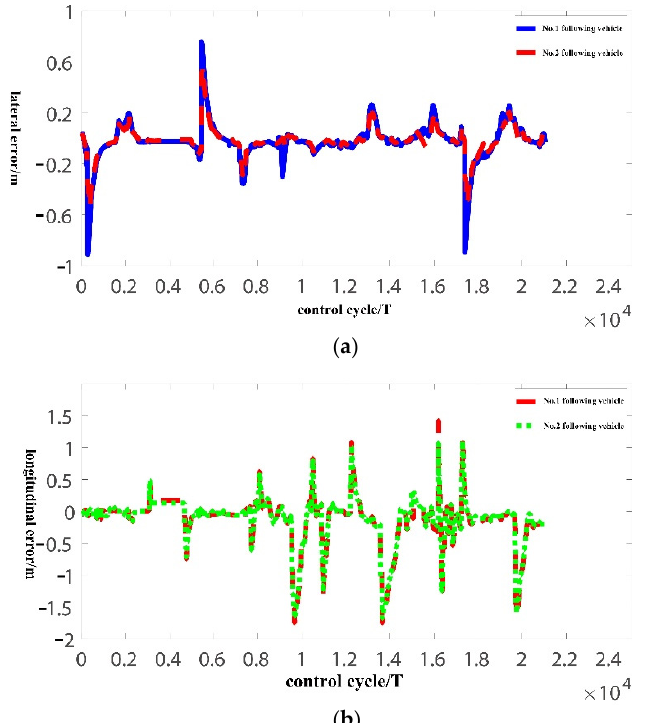
Figure 10. Lateral and longitudinal error curve of bus platoon. ( a ) Platoon lateral error curve; ( b ) Platoon longitudinal error curve.